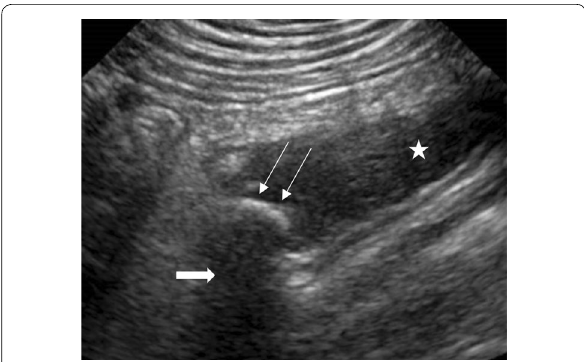
Fig. 1 Appendicolith: Ultrasound abdomen of the right lower quadrant showing an appendicolith (long thin arrows), which is the echogenic area within the appendix lumen (distal appendix) (star). There is a posterior acoustic shadowing seen behind the echogenic foci (thick arrow). The largest appendix diameter measured was 16